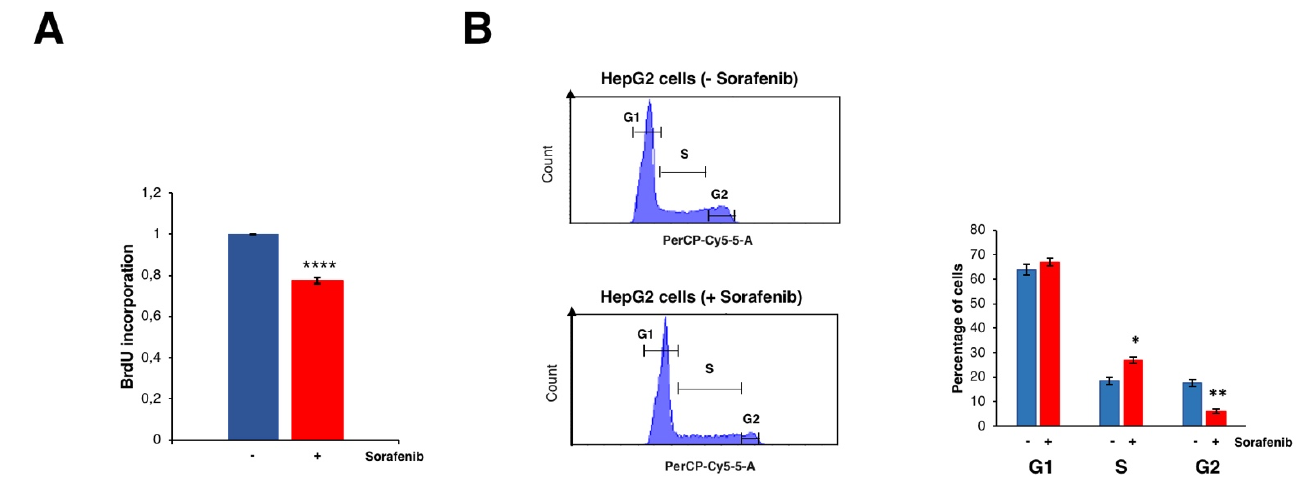
Figure 4. Effects of Sorafenib on cell proliferation and cell cycle. ( A ) BrdU incorporation assay on HepG2 cells treated or not with 10 µ M Sorafenib. Results are expressed as the mean ± S.D. of three independent experiments. Statistical significance was analyzed using Student’s test (**** p < 0.0001). ( B ) Cell cycle profiles obtained by FACS of HepG2 cells treated or not with 10 µ M Sorafenib. For measuring DNA content, cells were stained with propidium iodide. G1, S and G2/M phases are indicated. The percentage of cells at the different phases are shown in the histogram. Results are expressed as the mean ± S.D. values of three independent experiments. Statistical significance was analyzed using Student’s test (* p < 0.05; ** p <